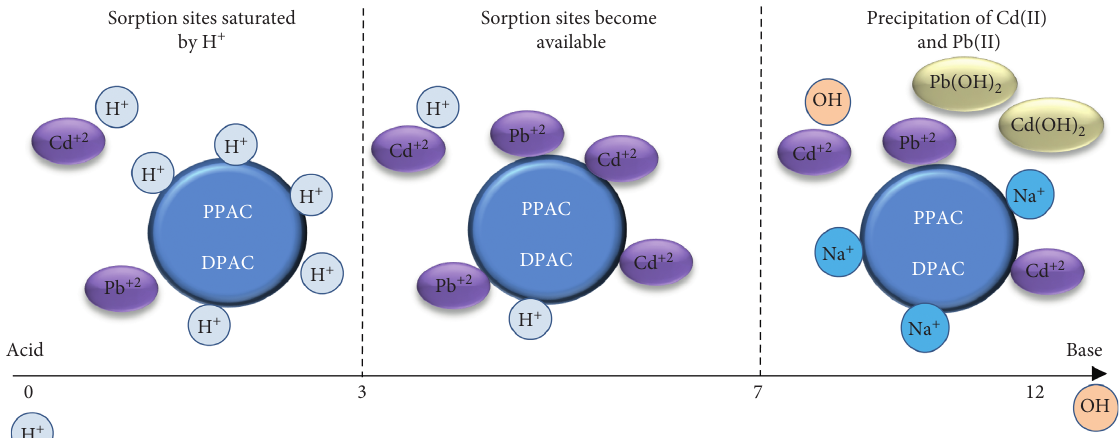
Figure 6: Effect of pH on the adsorption of Cd(II) and Pb(II) onto PPAC and DPAC at different pH